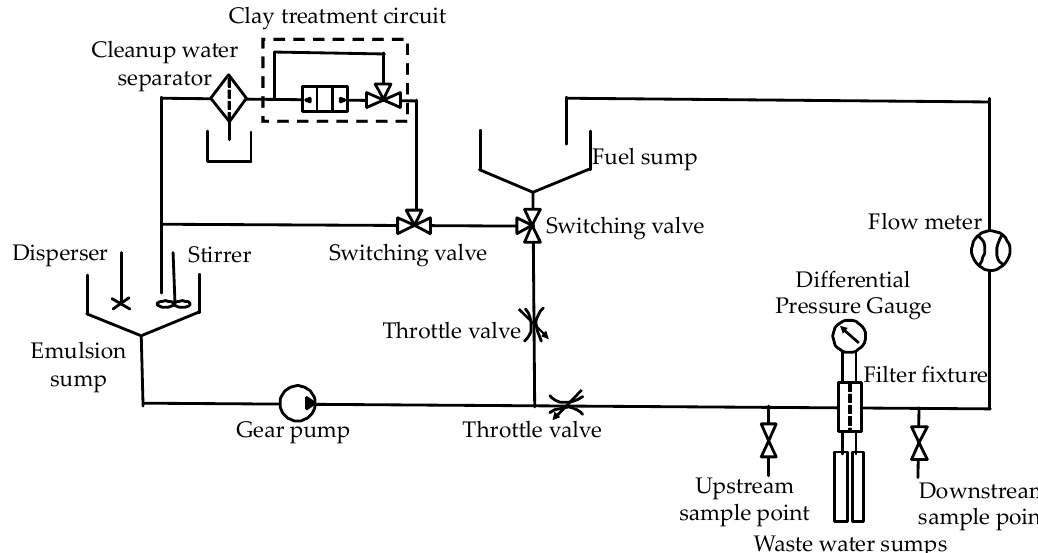
/ water separation test rig for filter media.